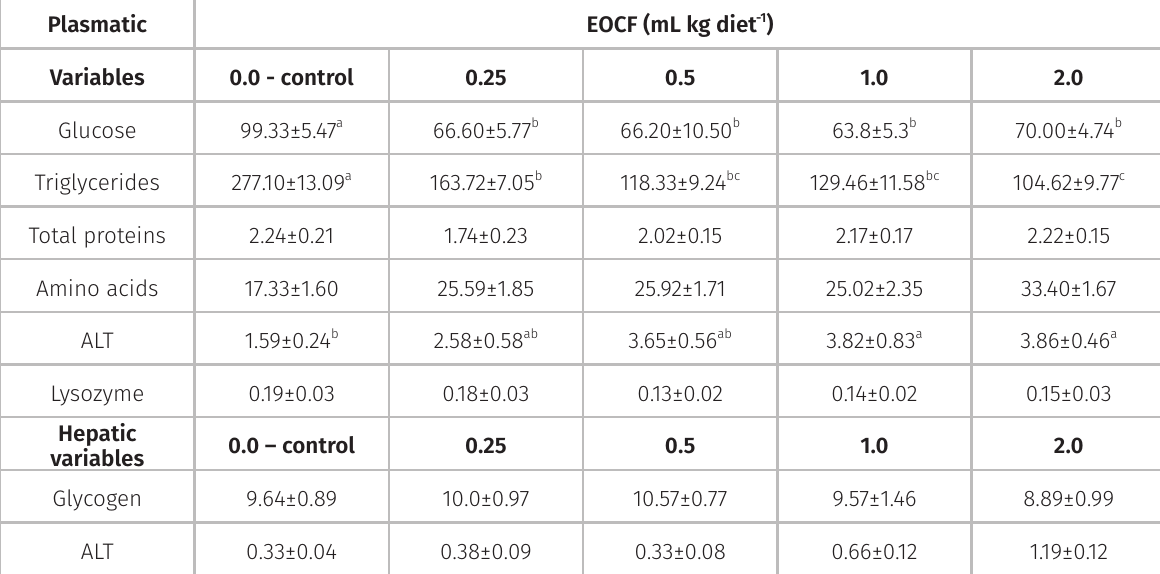
Table IV. Biochemical variables of plasma and liver of Nile tilapia fed with diets containing different concentrations of the essential oil of Cymbopongon flexuosus